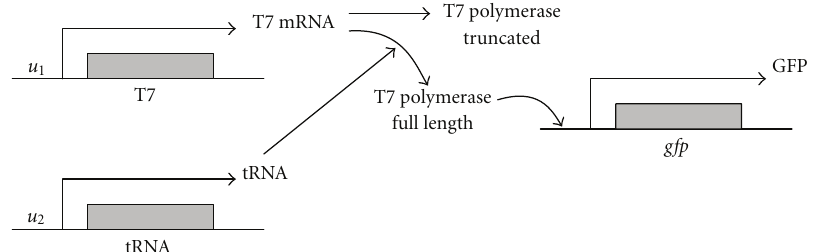
Figure 4: Synthetic gene AND gate. The input signal u 1 leads to the transcription of T7 polymerase gene, containing an early stop codon in the coding sequences that block translation. The input signal u 2 leads to the synthesis of a suppressor tRNA, which prevents the premature termination and enables the translation of polymerase. When both of these inputs are present, the functional T7 RNA polymerase leads to the synthesis of the output signal, the reporter protein